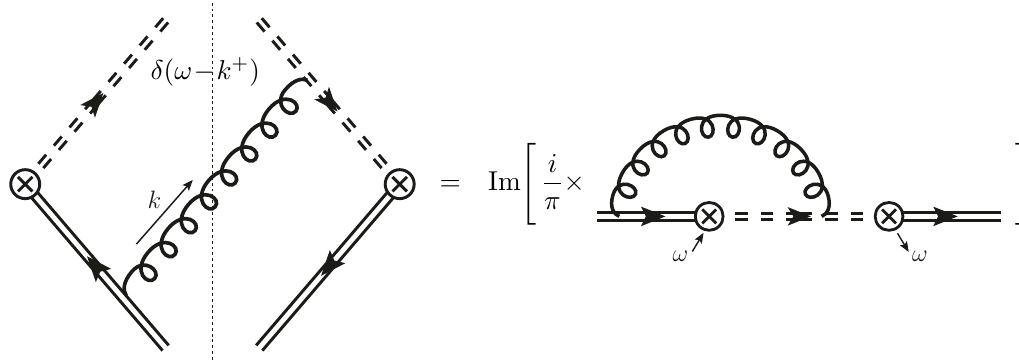
Figure 1 . The cut diagram on the left hand side represents one O ( (cid:11) s ) contribution to S hl in eq. (2.1). The phase space integration of the soft gluon (with outgoing momentum k (cid:22) ) crossing the (cid:12)nal state cut is restricted by the measurement function (cid:14) ( ! (cid:0) n (cid:1) ^ p ). The equivalent contribution to the expression in eq. (2.16) comes from the loop diagram on the right hand side, where the external lightcone momentum ! is routed through the light-like Wilson line as indicated. Here and in the following dashed double lines represent light-like Wilson lines ( Y ) and solid double lines represent time-like Wilson lines ( X ). The arrows on the Wilson lines indicate the fermion (cid:13)ow of the respective original quarks, which coincides with the direction of the path as well as the time ordering in this